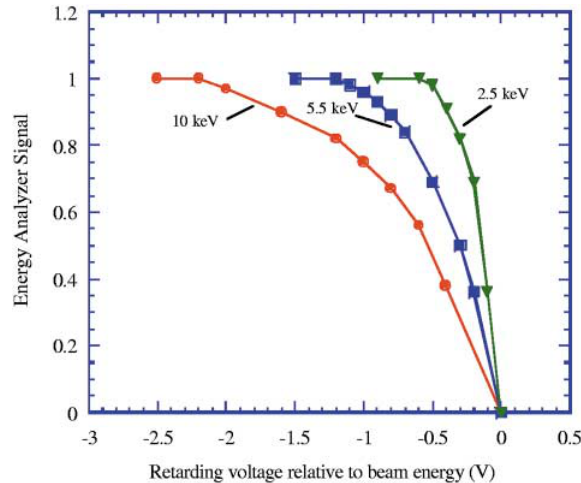
FIG. 5. (Color) Energy analyzer response curves to a monoen- ergetic beam at different beam energies of 2.5, 5.5, and 10 keV,